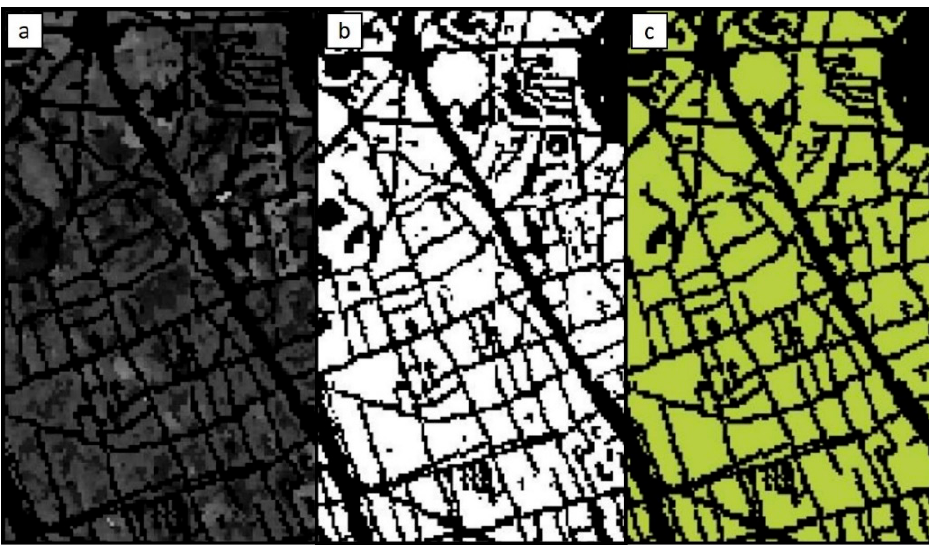
Figure 3. Image preprocessing. ( a ) Original GIS image in grey scale (grey levels are proportional to the height, with black being zero elevation). ( b ) Black and white binarized image (in black the streets, i.e., the pixels with zero height, in white the buildings, i.e., the non-zero height pixels). ( c ) Filtering of the internal courts and determination of the external border of buildings.